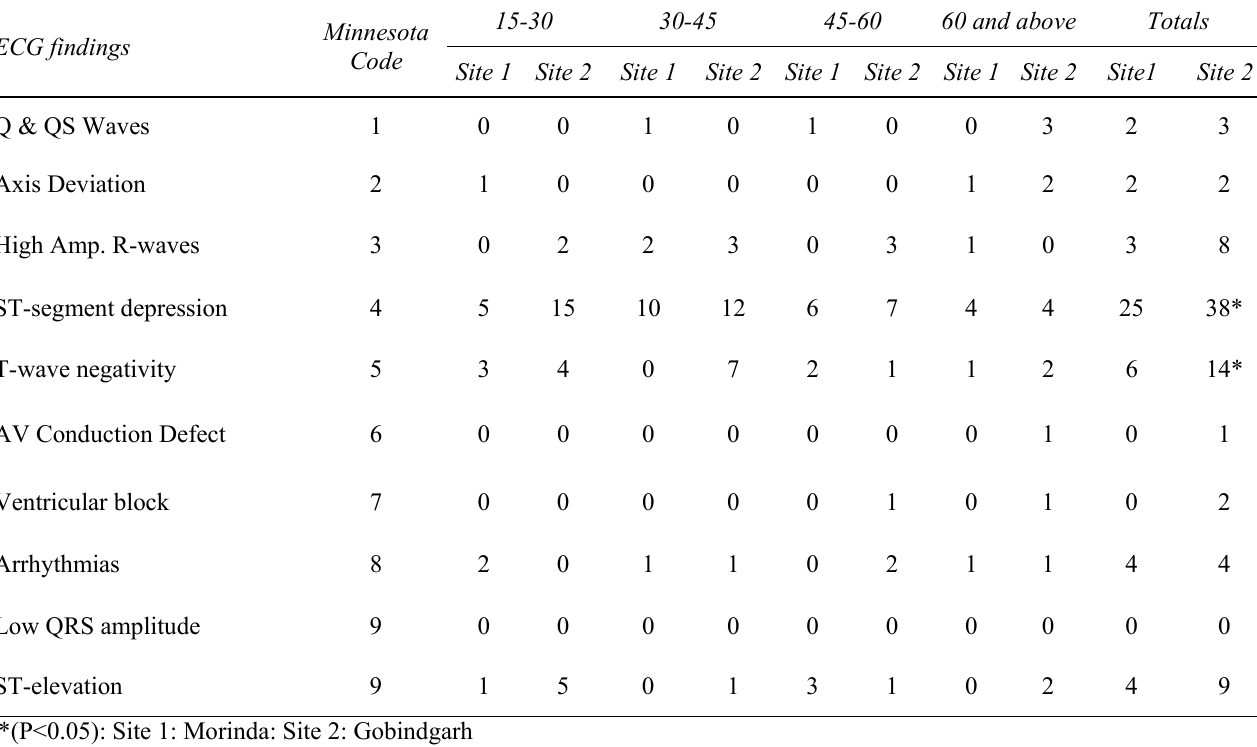
Table 8(b) : Frequency of various Minnesota codes in the female population of different age groups in the two study sites.